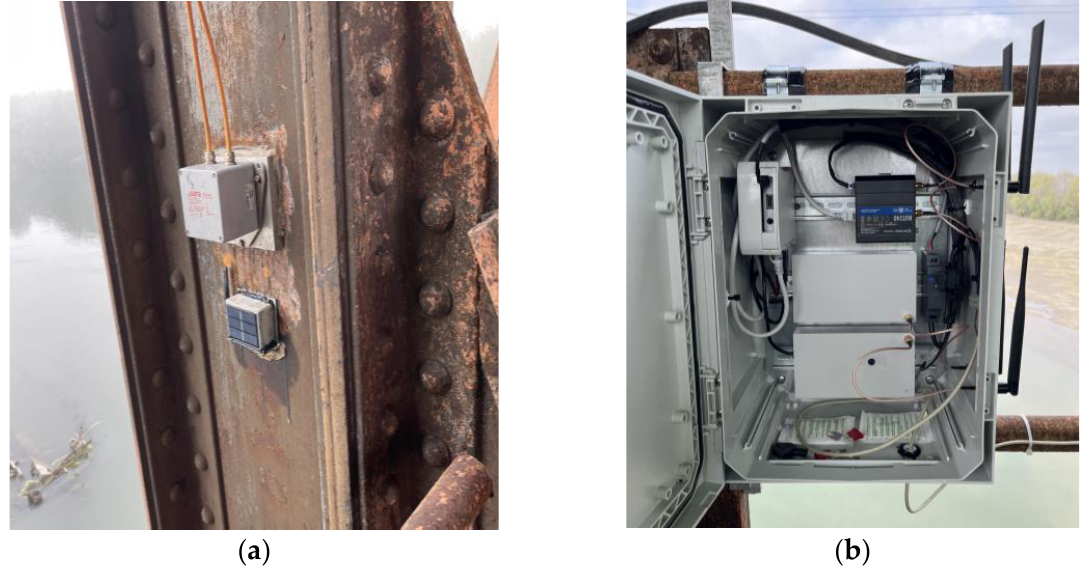
Figure 6. Wireless monitoring system mounted on the bridge: ( a ) Wireless sensor positioned in correspondence of a wired velocimeter; ( b ) gateway installed on a balcony of the railway deck.